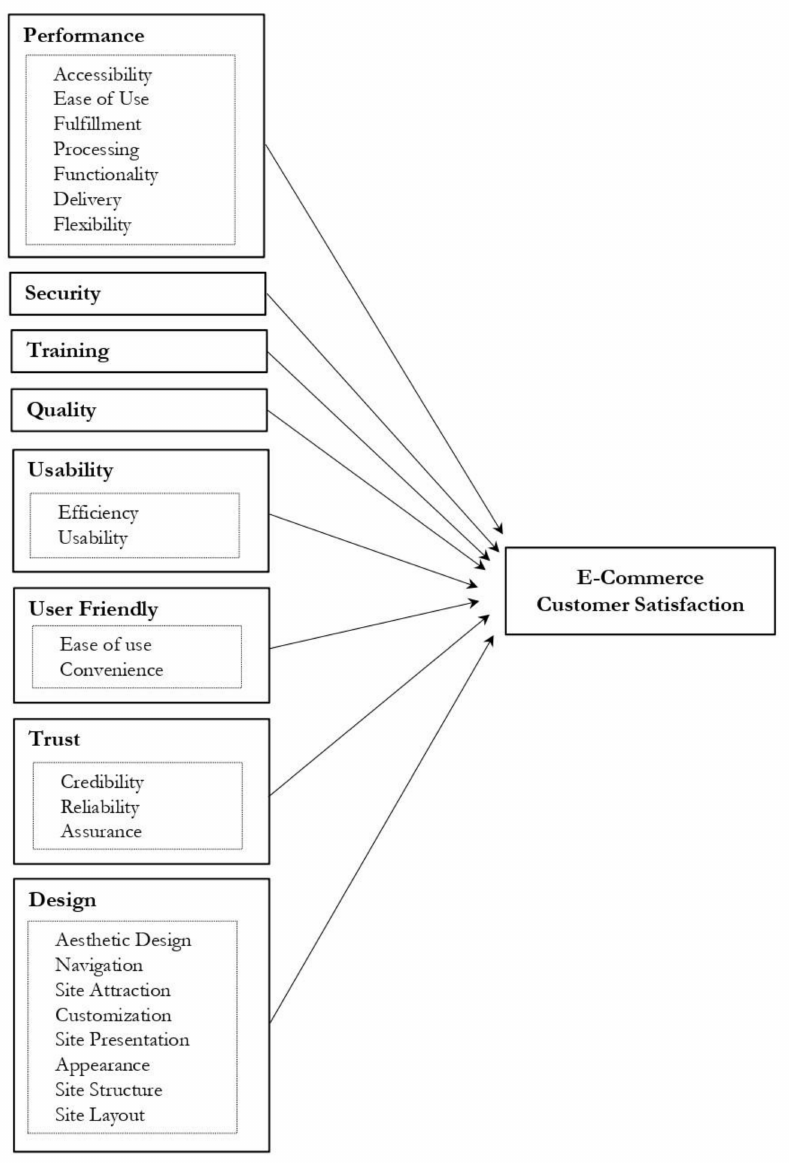
Figure 2. E-service satisfaction model